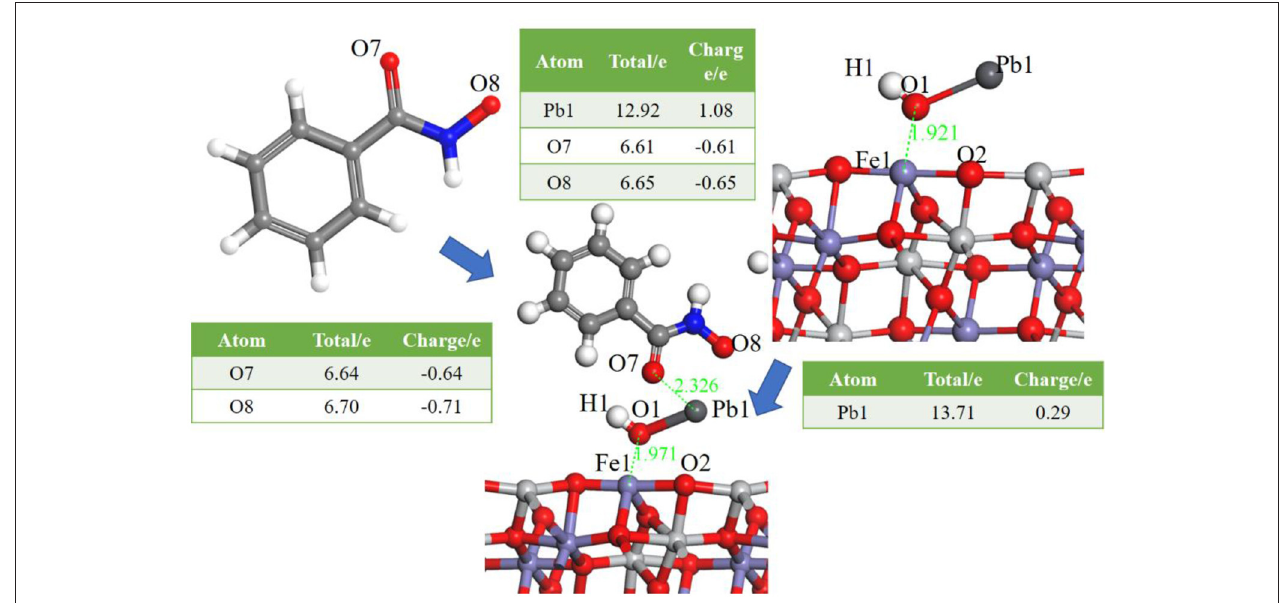
FIGURE 4 | Models of BHA on the Pb(OH) + -functioned ilmenite surface, the Table is the atom population before and after the adsorption of